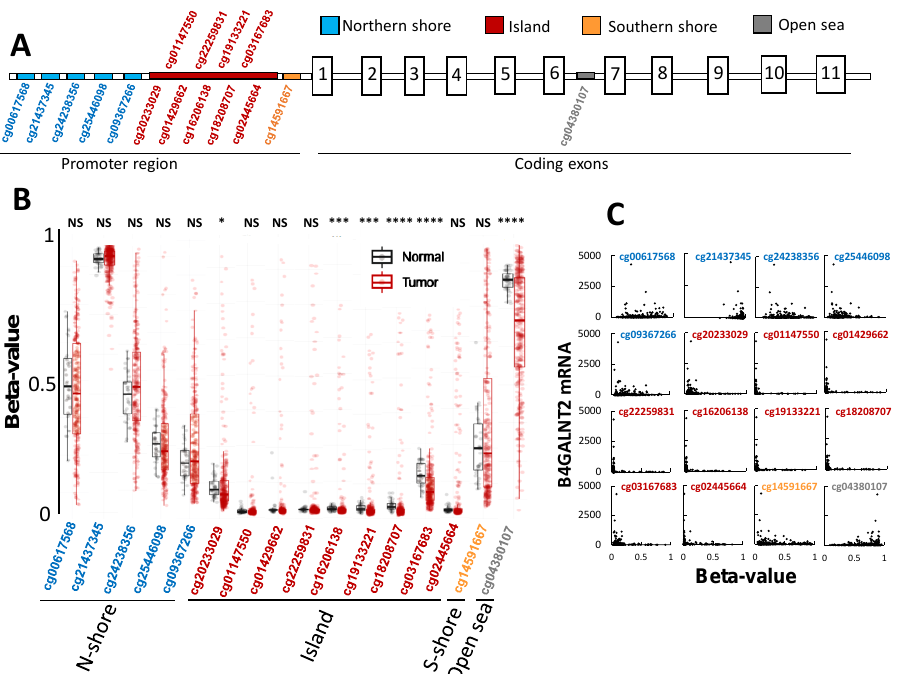
Figure 4. DNA methylation of the B4GALNT2 gene. ( A ) Schematic representation, not drawn to scale, of the promoter region and of the coding exons of the B4GALNT2 gene. The approximate position of the probes is indicated. ( B ) Methylation level of the different probes. * p < 0.05; *** p < 0.001; **** p < 0.0001. ( C ) Correlation between B4GALNT2 expression level and methylation of specific positions in tumor tissues.